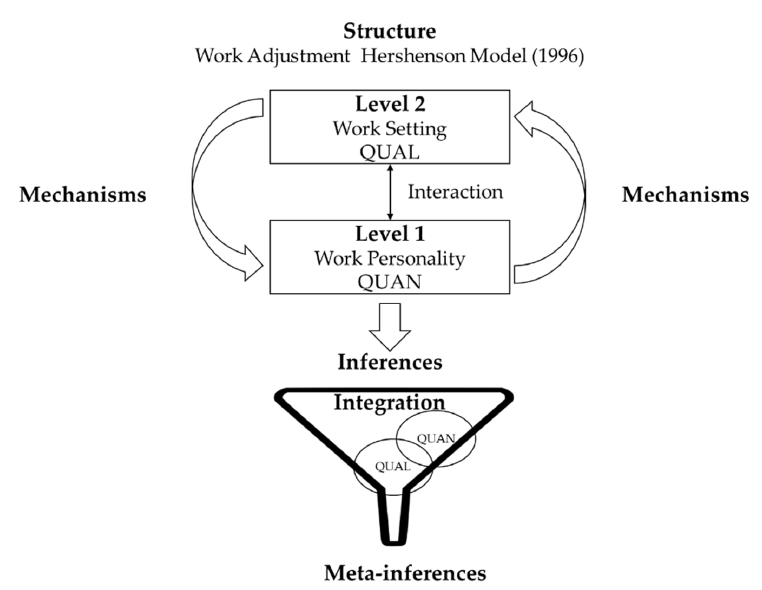
Figure 2. Conceptualization of the multilevel mixed ‐ methods research design.